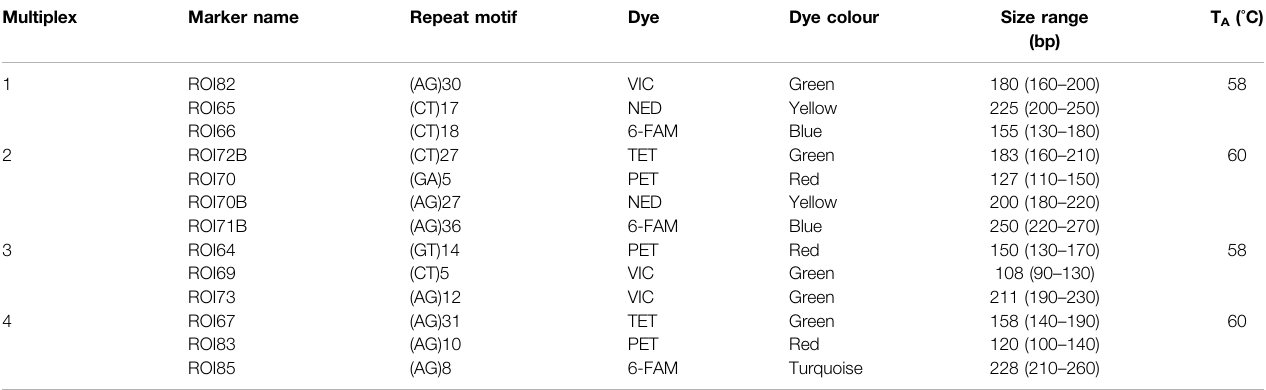
TABLE 2| Multiplexassayfor13 Aspalathuslinearis species-speci fi cnuclearmicrosatellitemarkers,wheretherepeatmotif,dye,sizerange(bp),and annealingtemperature (T A ) are